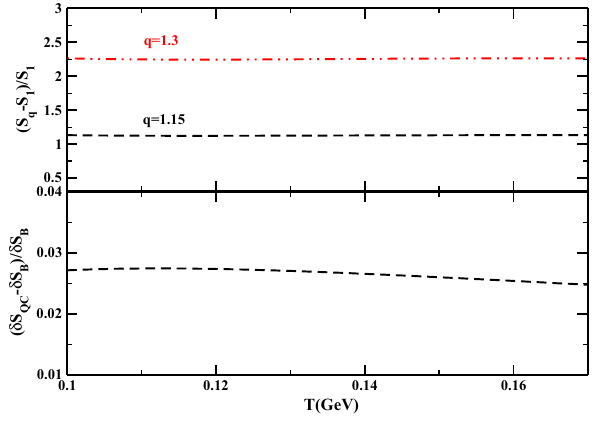
Fig. 3 The non-extensive correction and the quantum correction over non-extensivity of the entropy of the system